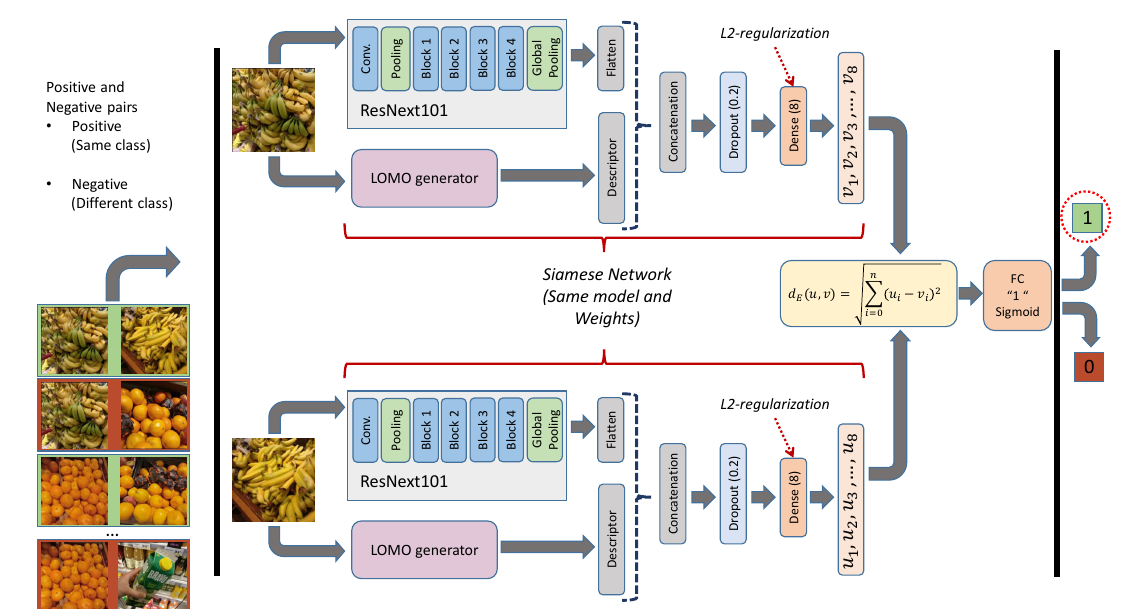
Figure 6. Third approach: Siamese net with ResNeXt-101-32x8d and LOMO